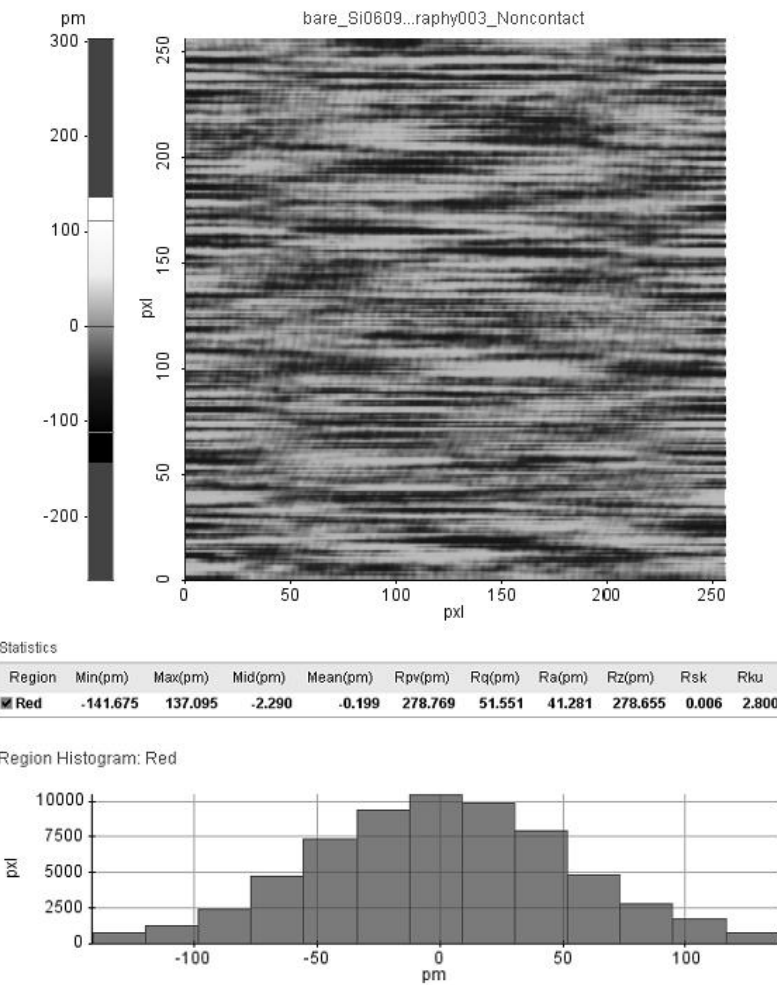
Figure 11. Vertical nulling resolution of the TS-AFM. Top: NC-AFM image. Middle: statistics. Bottom: